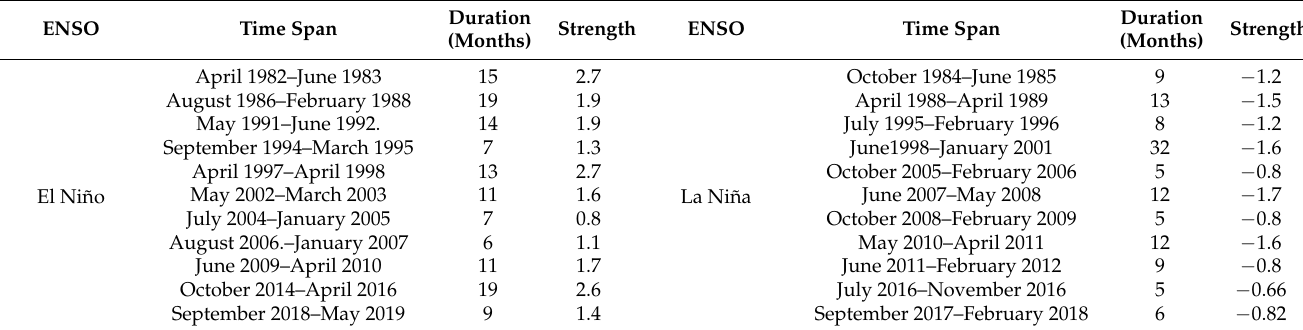
Table 3. Identification of El Niño and La Niña from 1980 to 2018 using the Niño3.4 index and the NCC/CMA